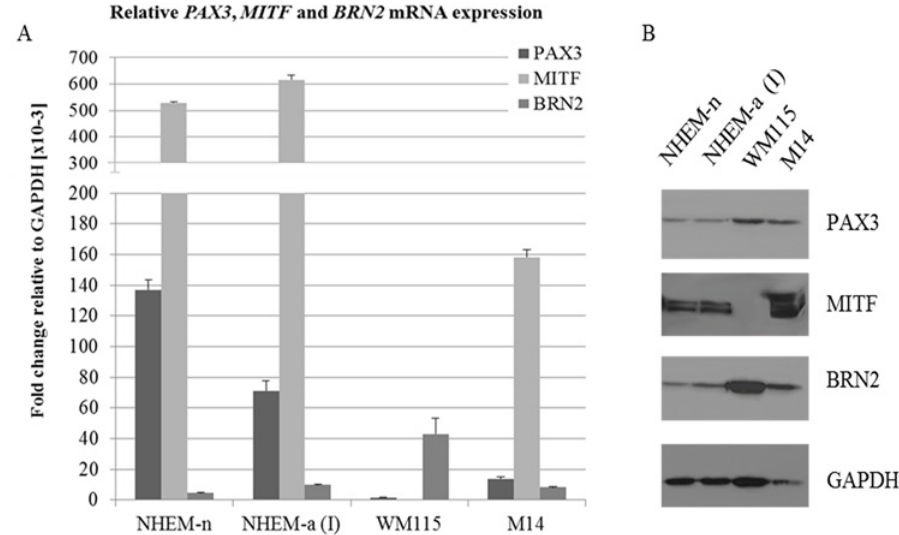
Fig 4. PAX3-MITF-BRN2 regulation axis in a selected panel of melanocytes and melanoma cell lines. A) PAX3 , MITF and BRN2 mRNA expression levels in melanocytes and melanoma cells. RT-qPCR was performed to assess expression levels of PAX3 , MITF and BRN2 mRNA in primary melanocytes and melanoma cell lines. All PCRs were performed in triplicate and expression values were calculated as fold change relative to GAPDH . Biological replicates were performed for each sample and error bars denote the standard deviation between biological replicates. B) PAX3, MITF and BRN2 protein levels in primary melanocytes and melanoma cells. Total protein from primary melanocytes and melanoma cells was separated by SDS-PAGE and immunoblotted with anti-PAX3, anti-MITF, anti-BRN2 and anti-GAPDH.